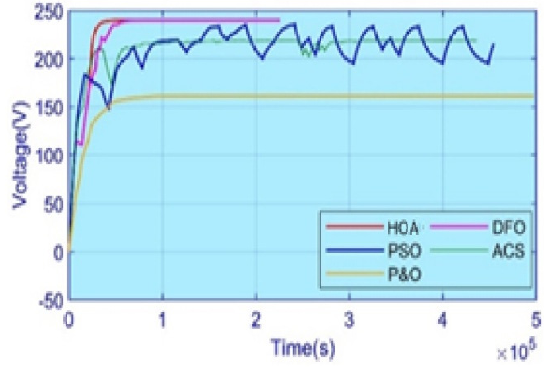
Figure 23. Comparison of the HOA voltage for Case 4 .